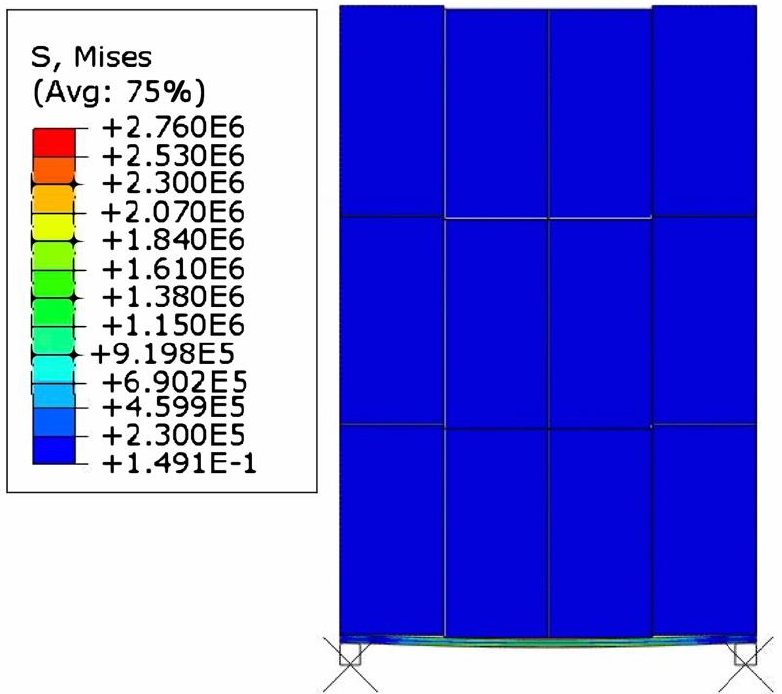
Figure 6. Plot of the equivalent Von Mises (MPa) stress of the unit load segment under a 4-column